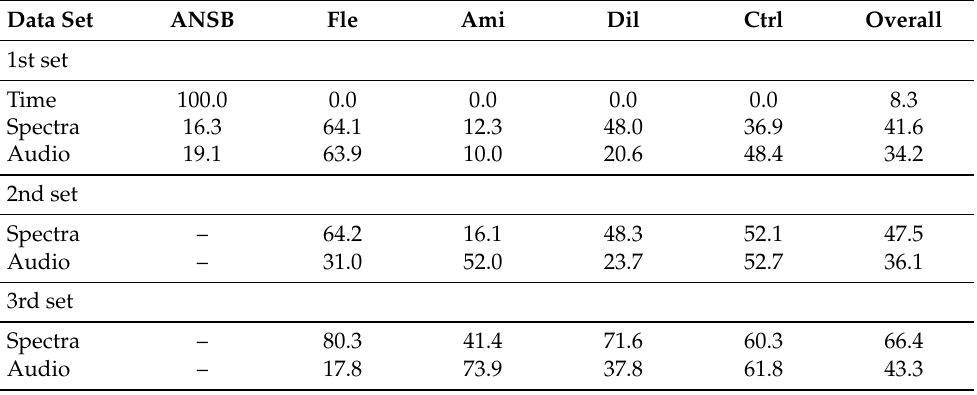
Figure 5. Latent space before ( left ) and after ( right ) fine-tuning using the second dataset and the frequency domain features. Table 2. Accuracy percentage of unsupervised learning autoencoders with several in-order training sets.